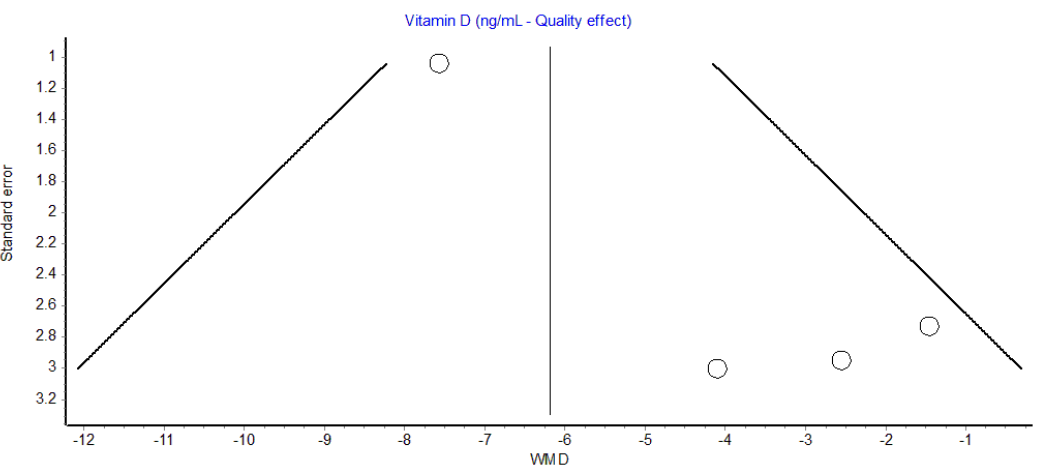
Figure 2. Funnel plot of observational studies reporting serum vitamin D concentration in patients with or without tinnitus. WMD, weighted mean difference.